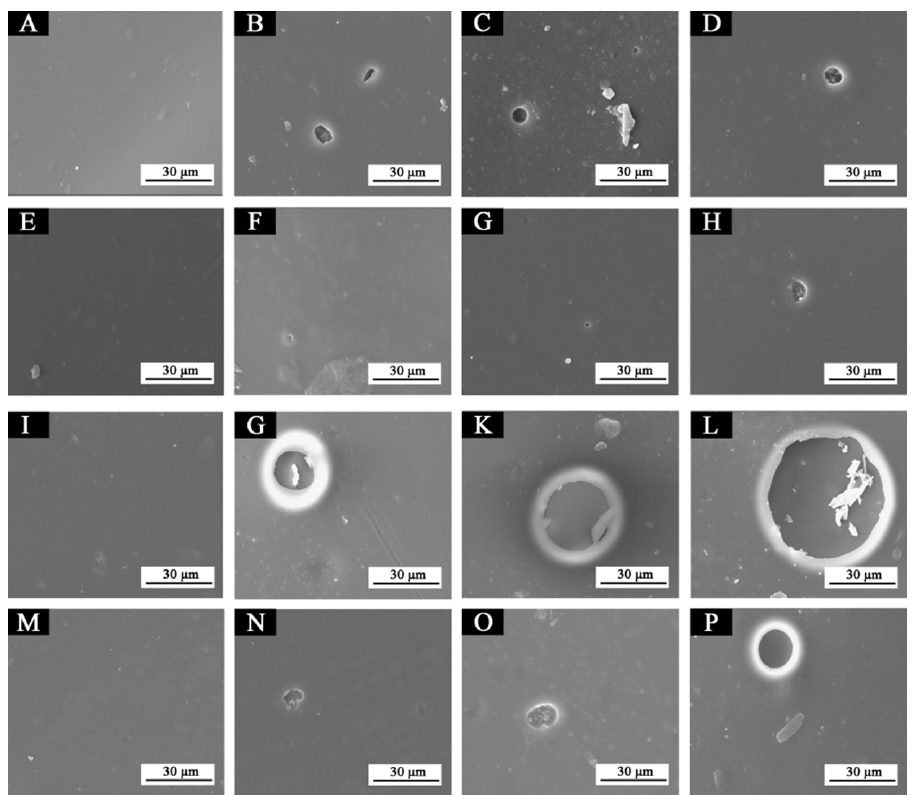
Figure 16. SEM of paint films before and after aging in different environments: ( A ) 5#, ( B ) 5#-120 °C, ( C ) 5#-160 °C, ( D ) 5#-UV, ( E ) 7#, ( F ) 7#-120 °C, ( G ) 7#-160 °C, ( H ) 7#-UV, ( I ) 11#, ( J ) 11#-120 °C, ( K ) 11#-160 °C, ( L ) 11#-UV, ( M ) 12#, ( N ) 12#-120 °C, ( O ) 12#-160 °C, ( P ) 12#-UV.